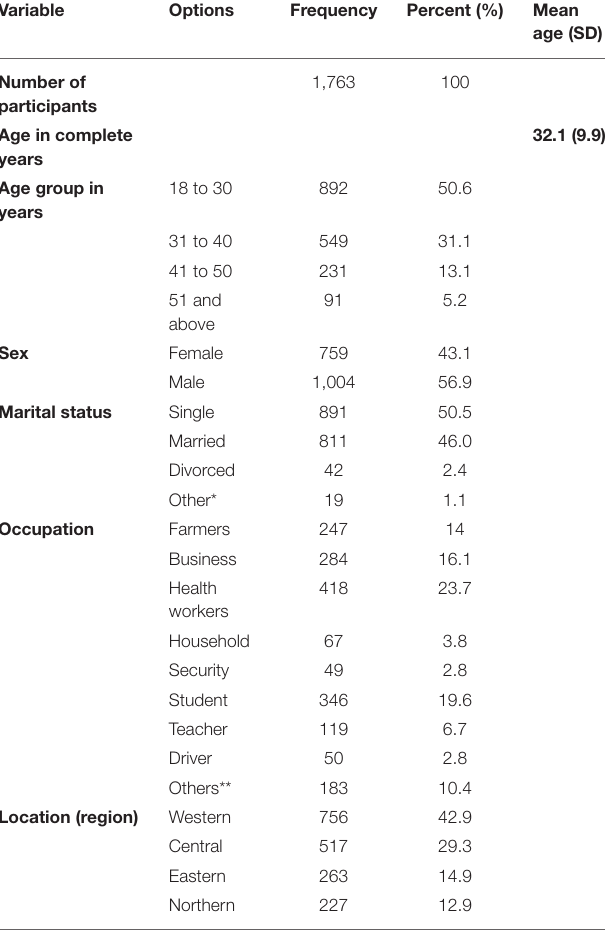
TABLE 2 | Ordered logistic regression of knowledge level with socio-demographic characteristics of